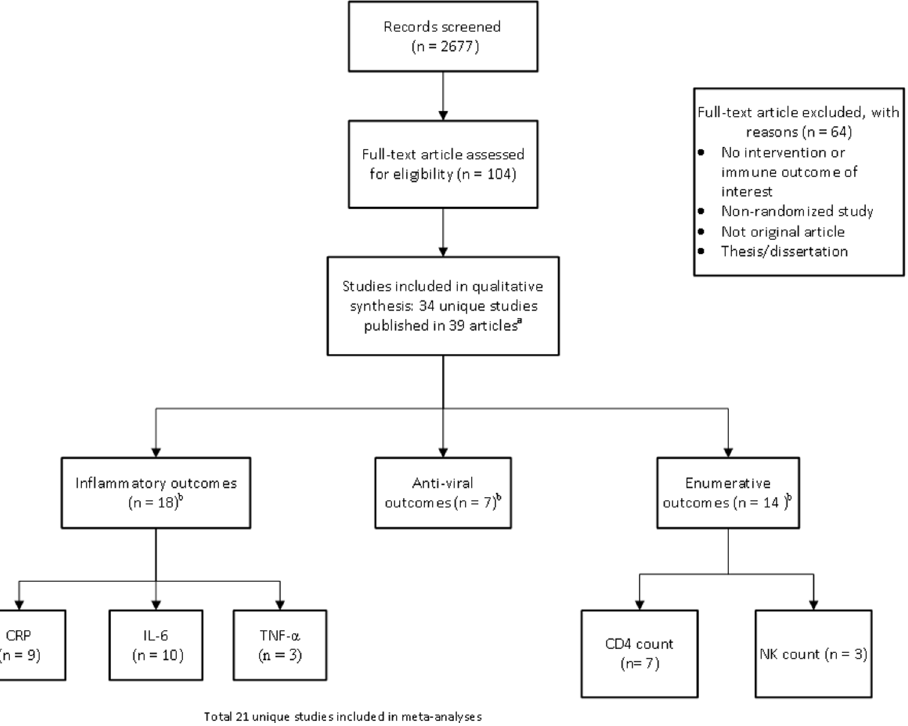
Figure 1. Literature Search and Study Selection. Legends: CD4=cluster of differentiation 4 protein; CRP=c-reactive protein; IL-6=interleukin- 6; INF- c =Interferon-gamma; NK count=natural killer cell count; TNF- a =Tumor necrosis factor. a The studies were conducted in 9 countries (United States, China, India, Australia, Spain, Germany, Iran, Norway, and the United Kingdom). b The sum of study number exceeds the total number of studies included due to some studies reported multiple outcomes across